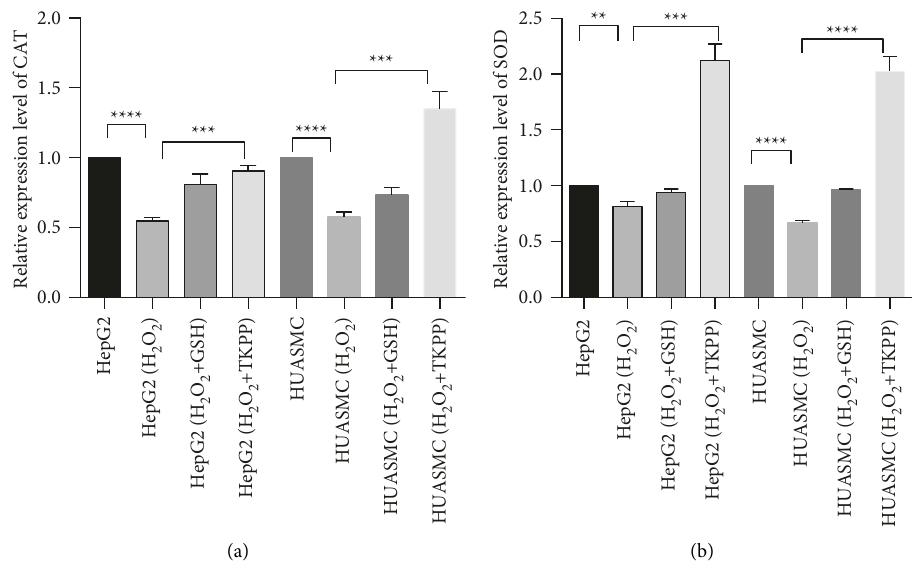
Figure 3: Effects of TKPP on the expression of CAT (a) and SOD (b) in oxidative-damaged HepG2 and HUASMC cells. ∗∗ P < 0 . 01, ∗∗∗ P < 0 . 001, and ∗∗∗∗ P < 0 . 0001. Protein expression detection of CAT and SOD in TKPP group.